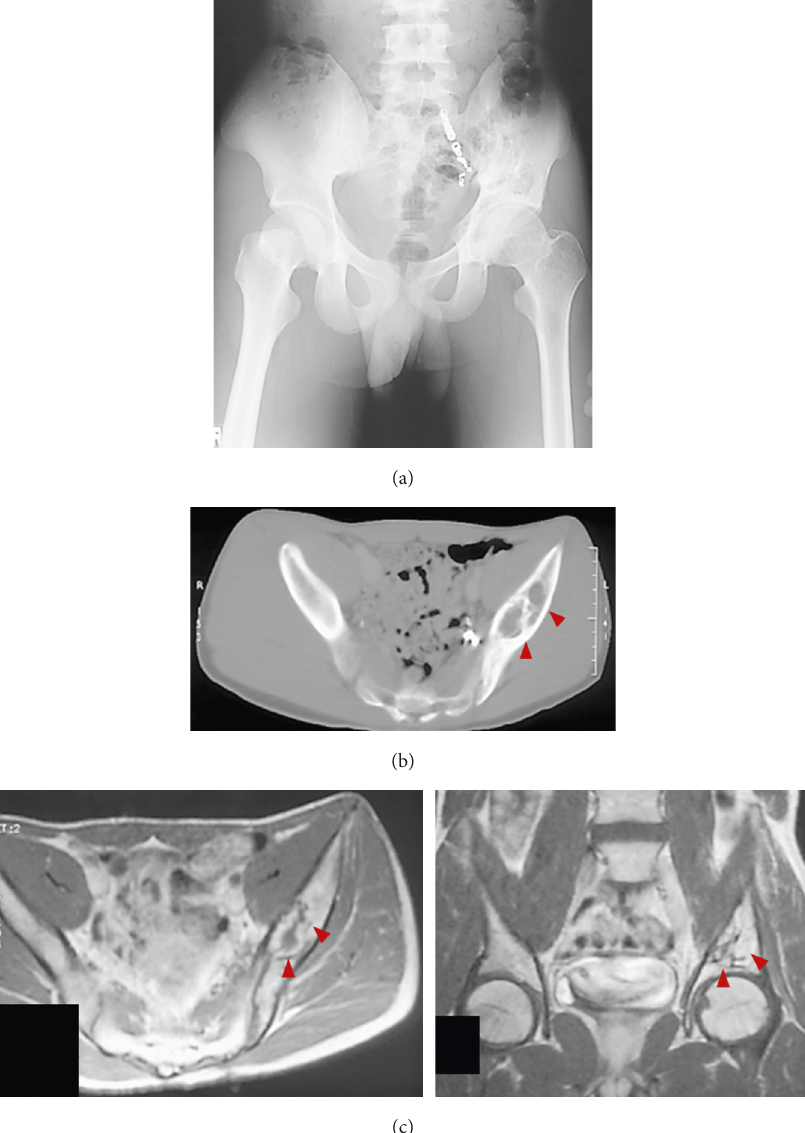
Figure 8: (a–c) 14 years after the surgery, the patient has remained with no evidence of